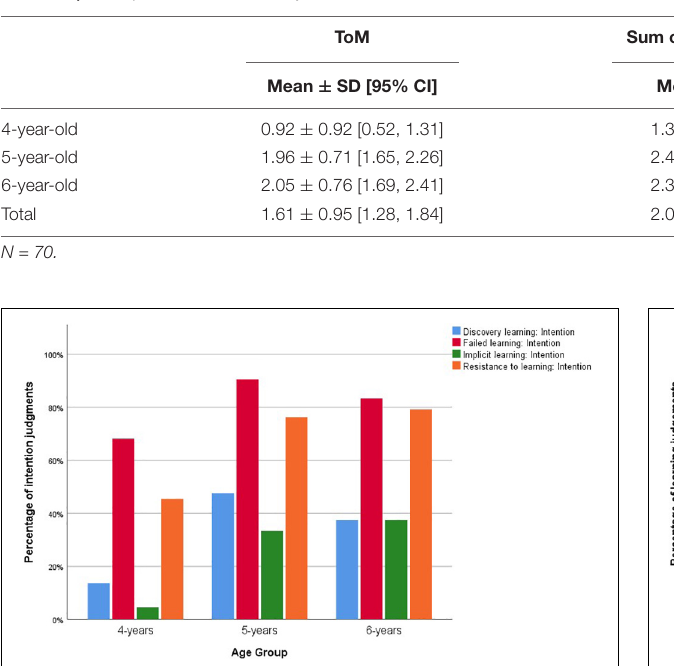
TABLE 4 | Descriptive statistics of study 2.